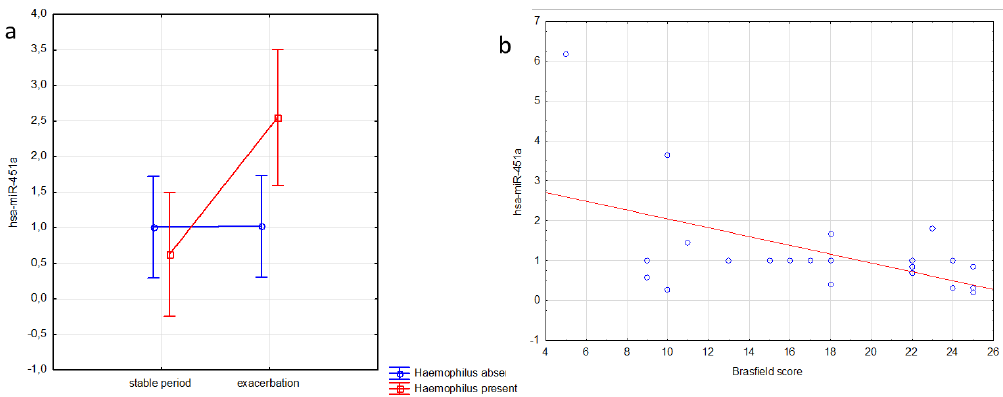
Figure 3. Association of miR-451a expression in EBC and clinical parameters in CF patients, ( a ) in relation to Hemophilus infection and exacerbation (F = 5.760; p = 0.024, 2-way analysis of variance); ( b ) correlation with the Brasfield score ( r = − 0.526; p = 0.001, Spearman correlation).